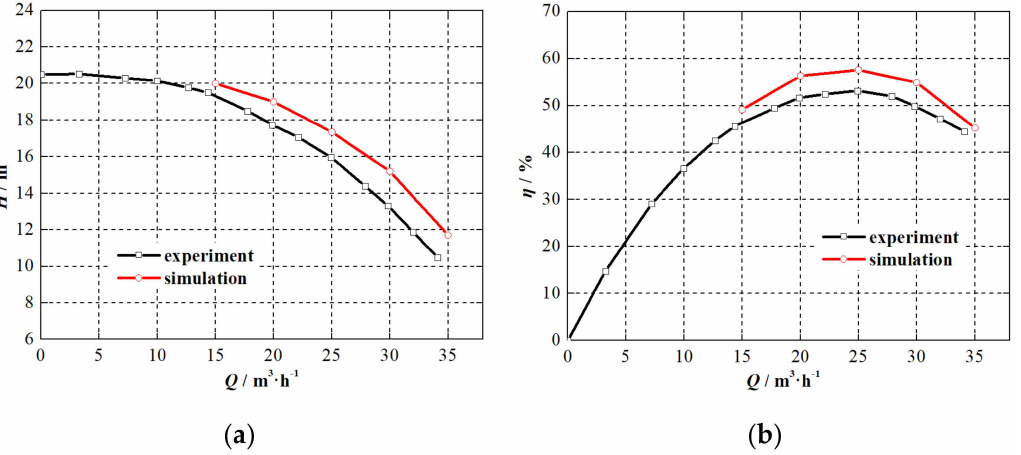
Figure 7. Comparison between simulated and tested performance characteristics of model pump.